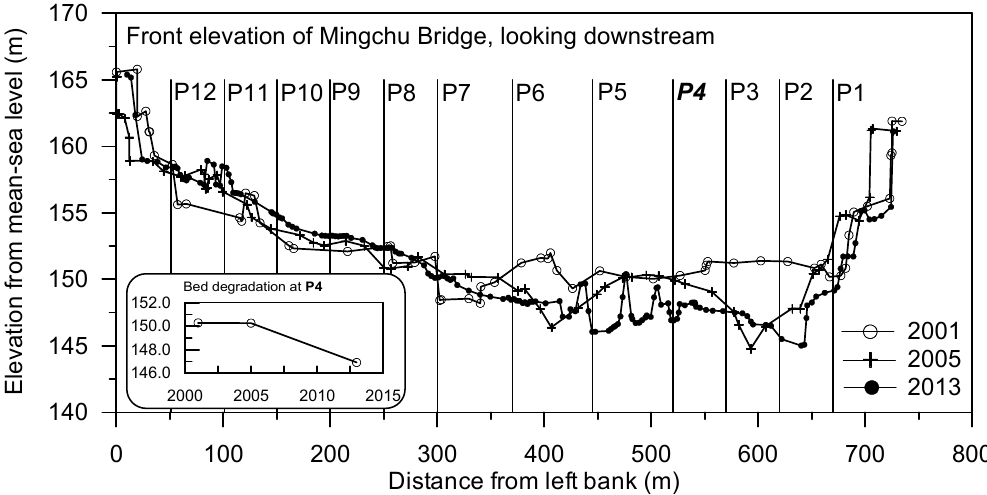
Figure 3. Cross section elevation of the Mingchu Bridge, looking downstream.